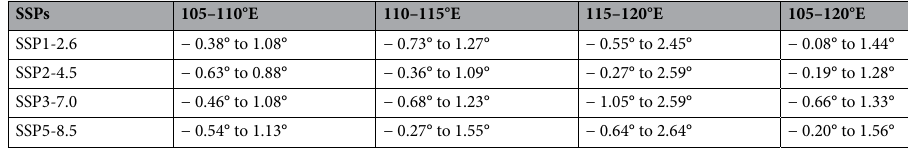
Table 3. The range of meridional migration of the EASM northern boundary. The range is the meridional migration of the EASM northern boundary since the twenty-first century relative to present day within the region of 105–110°E, 110–115°E, 115–120°E, 105–120°E under SSP1-2.6, SSP2-4.5, SSP3-7.0, and SSP5-8.5